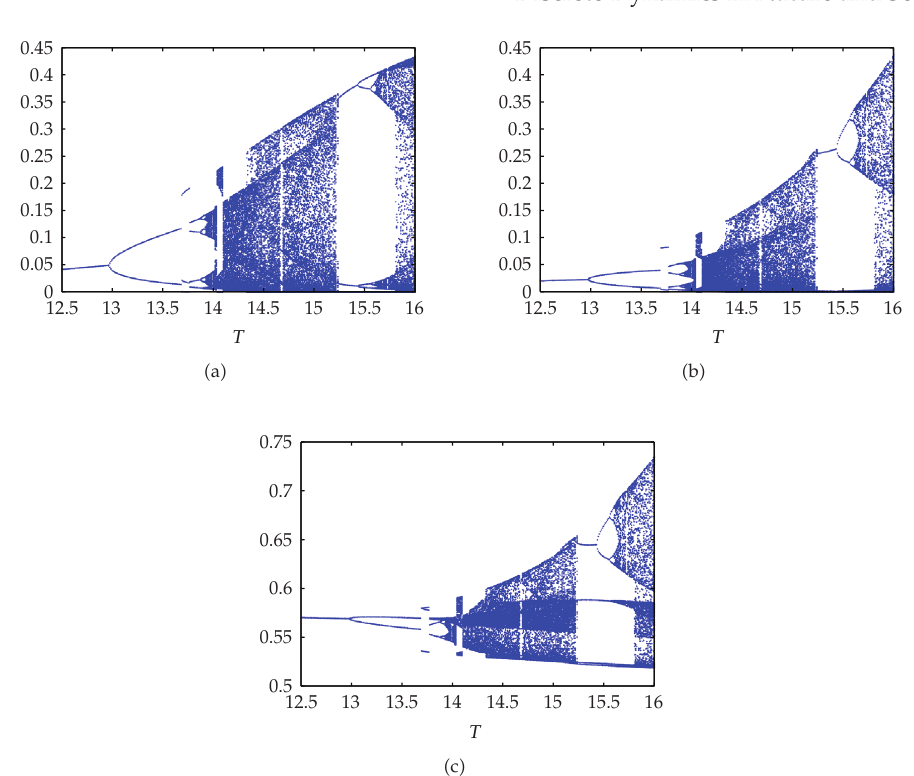
Figure 2: Bifurcation diagrams of system (cid:2) 1.1 (cid:3) showing the e ff ect of T with r (cid:6) 1 , a (cid:6) 1 , b (cid:6) 4 , k (cid:6) 2 , m (cid:6) 0 . 8 , D (cid:6) 0 . 4 , v 1 (cid:6) v 2 (cid:6) 0 . 2 , l (cid:6) 0 . 5 , δ (cid:6) 0 . 1 , δ 1 (cid:6) 0 . 5 , δ 2 (cid:6) 0 . 1 , q (cid:6) 0 . 5 , 12 . 5 ≤ T ≤ 16 and initial values x (cid:6) 8 . 5 , y 1 (cid:6) 4 . 8 , y 2 (cid:6) 2 .